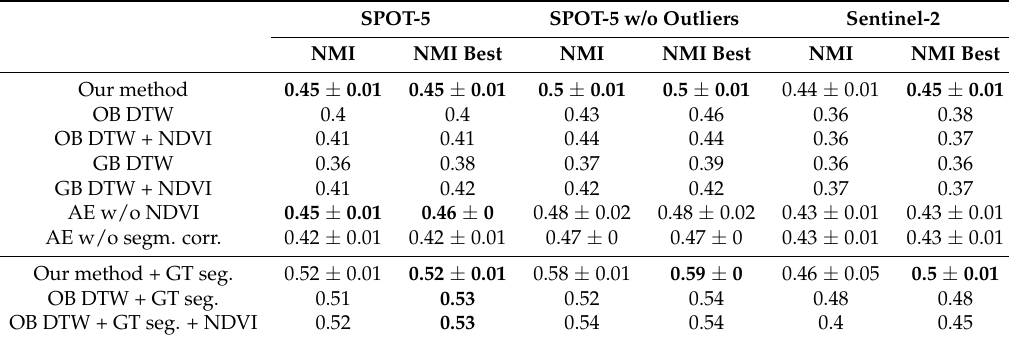
Table 4. Accuracy of different